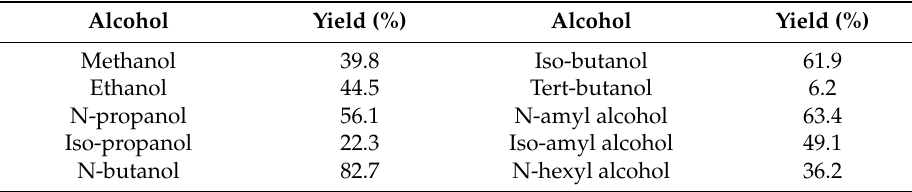
Table 3. The yield of butyrate synthesis catalyzed by